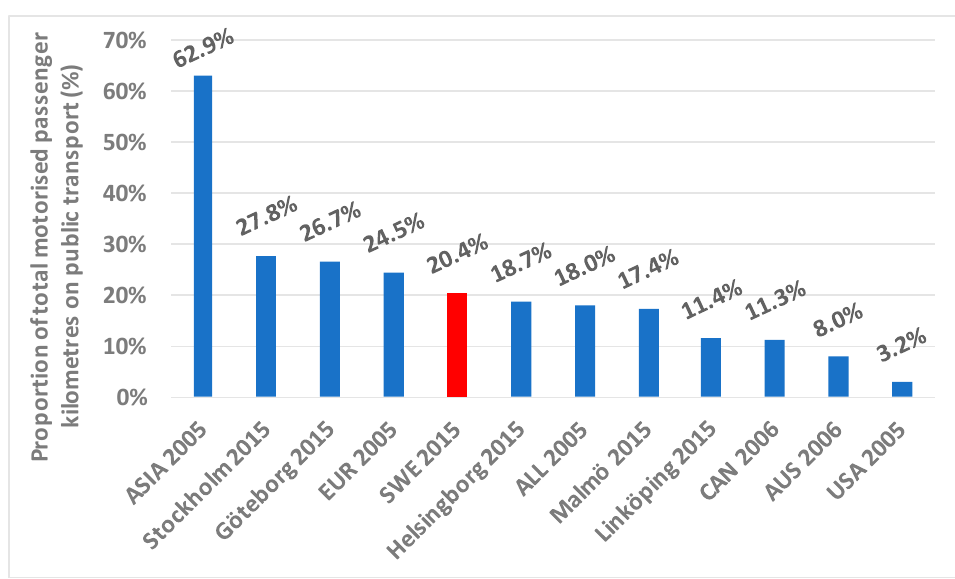
Figure 15. Relative speed of public transport versus general road traffic in five Swedish cities (2015) compared to a sample of global cities (2005–2006).